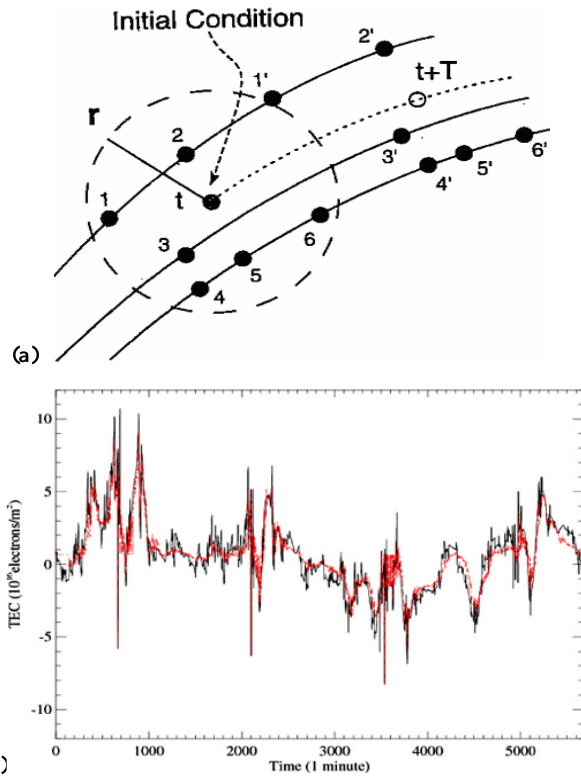
Fig. 7. Plots of (a) nearest-neighbour-based prediction in a state space, and (b) modeled (dashed red line) and observed values (solid line) of detrended TEC during the quiet period 7–10 June 2005, measured at